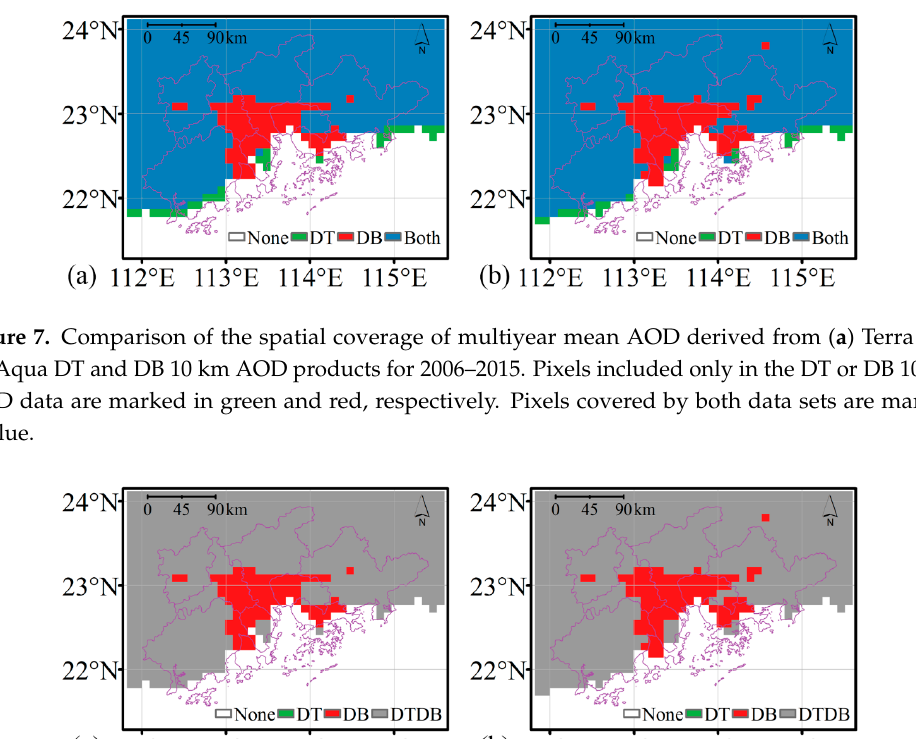
Figure 8. Spatial coverage of multiyear mean AOD derived from ( a ) Terra and ( b ) Aqua DTDB 10 km AOD products for 2006–2015. Pixels covered by the DTDB 10 km AOD are marked in grey. Green and red pixels indicate the regions where valid DT 10 km or DB 10 km retrievals, respectively, are not included in the DTDB 10 km product.